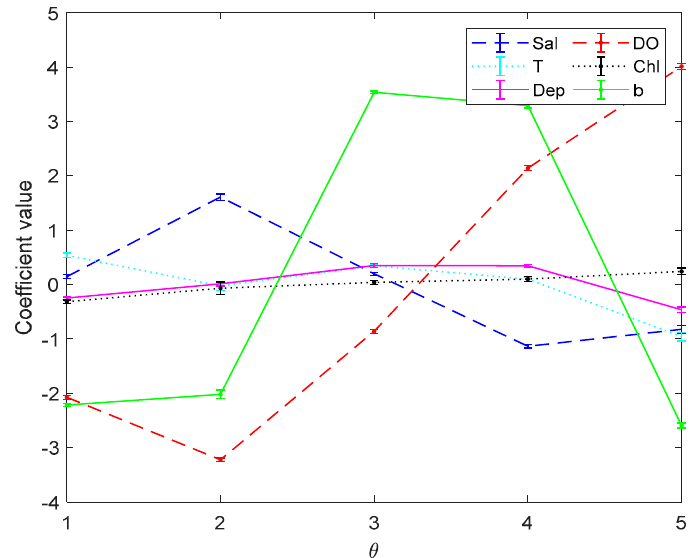
Figure 3. Coefficients by softmax regression before data preprocessing. Figure 3. Coe ffi cients by softmax regression before data preprocessing.